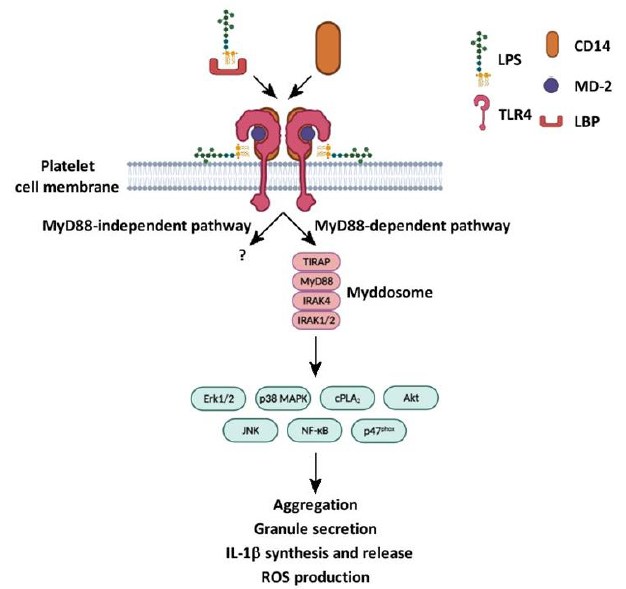
Figure 3. LPS–TLR4 signaling cascades in platelets. LPS initiates the MyD88-dependent signaling cascade, which in turn activates many downstream effectors (Erk1/2, p38 MAPK, cPLA 2 , Akt, JNK, NF- κ B, and p47 phox ), leading to or potentiating platelet aggregation, granule secretion, IL-1 β synthesis and release, and ROS production [10,12–17,19–21,44,45,50]. The role of MyD88-independent pathway is still